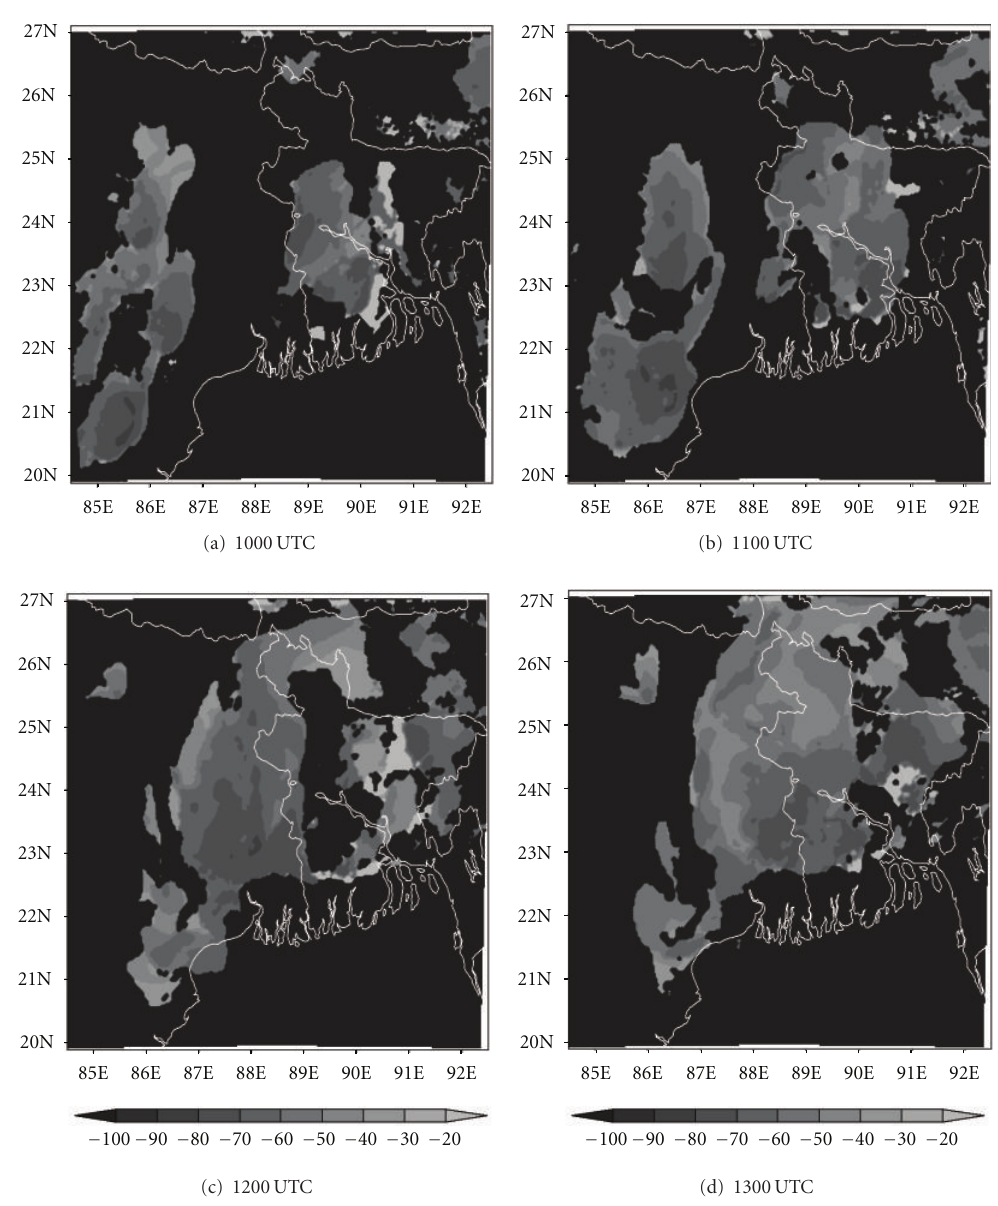
Figure 14: NMM-model-simulated cloud top temperature ( ◦ C) from 1000 to 1300 UTC on 03, May, 2009.